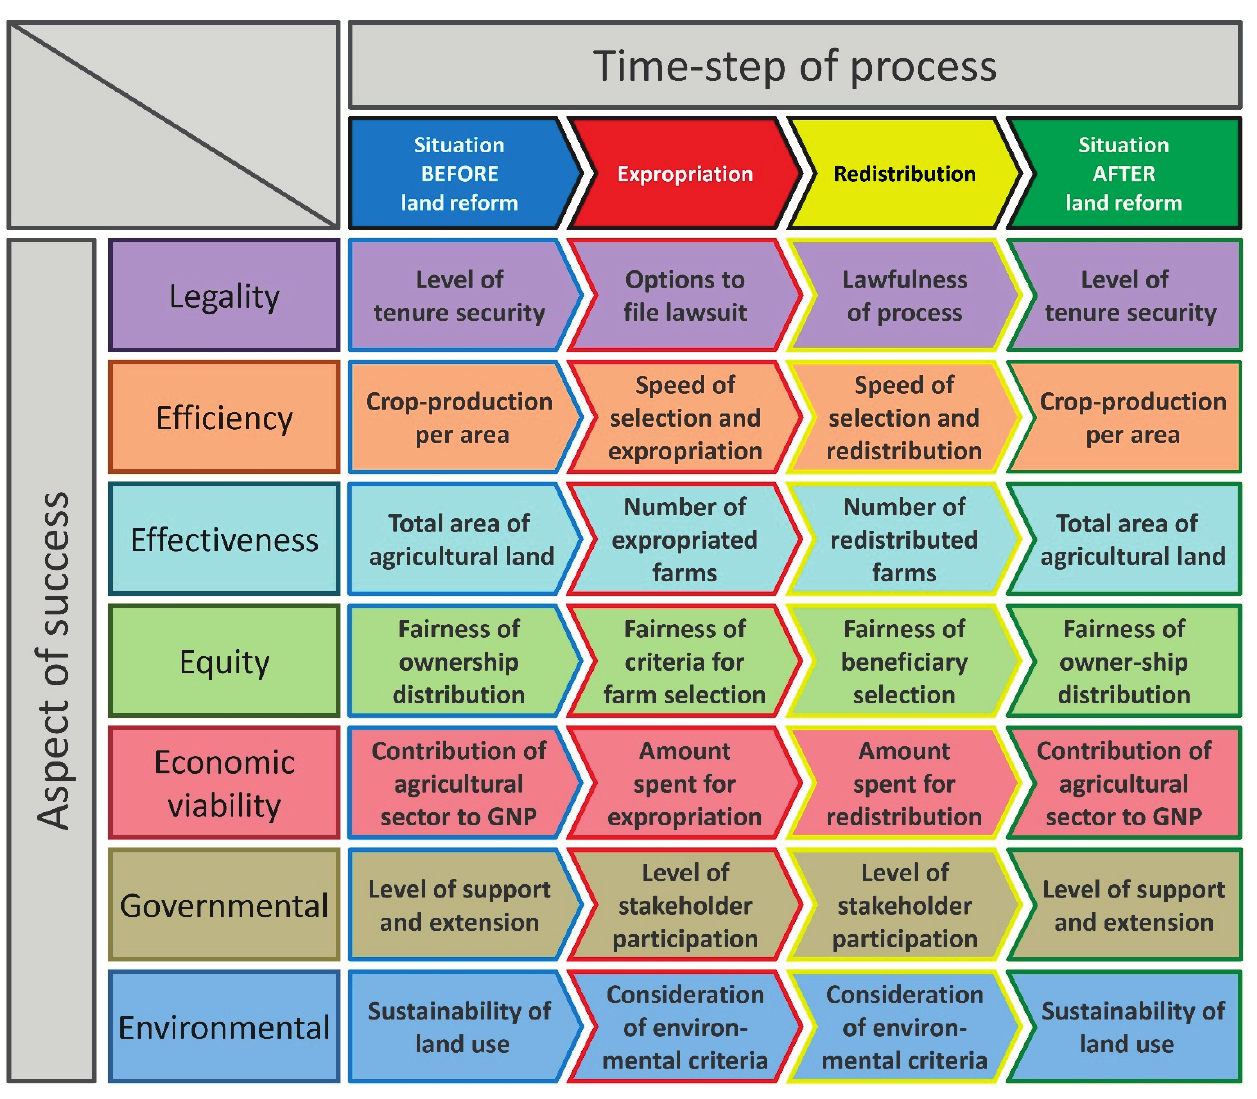
Figure 1. Structured overview of multidimensional land reform assessment